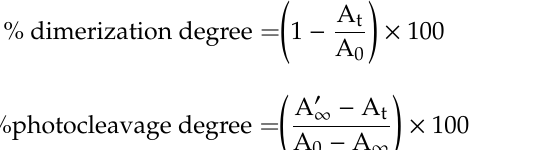
Table 1. Dimerization and cleavage conversions of coumarin derivatives .